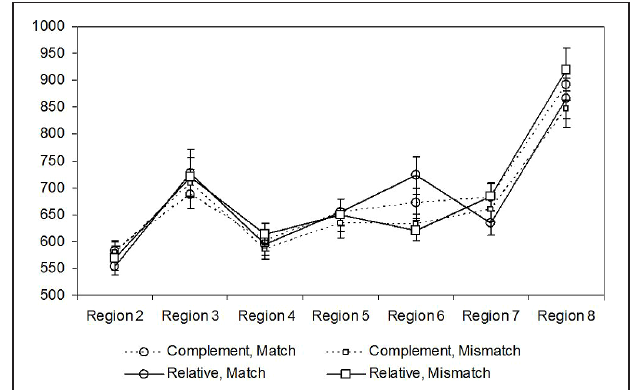
FIGURE 1 | Distribution of reading times (in ms) in the four experimental conditions of the different regions of Experiment 1. The critical region containing the test verb is Region